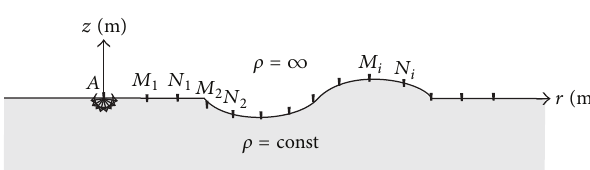
Figure 1: Scheme of vertical electrical sounding on a ground surface with